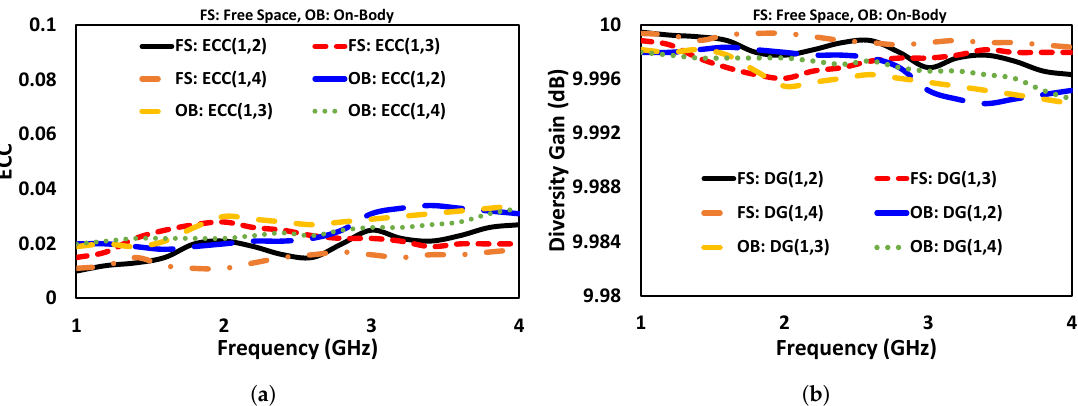
Figure 13. ( a ) The envelope correlation coefficient (ECC) and ( b ) diversity gain (DG) of the proposed MIMO